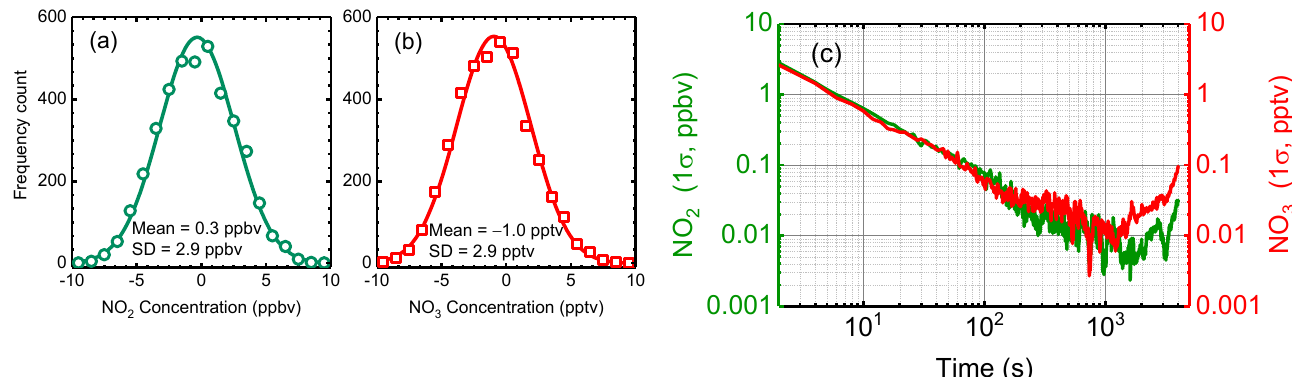
Figure 5. The standard and Allan deviation analysis result. ( a ) and ( b ) are the standard deviation of measured NO 2 and NO 3 in 2 s integration time, respectively, when the chamber was filled with zero air. ( c ) Allan deviation analysis result of the measurements of NO 2 and NO 3 .